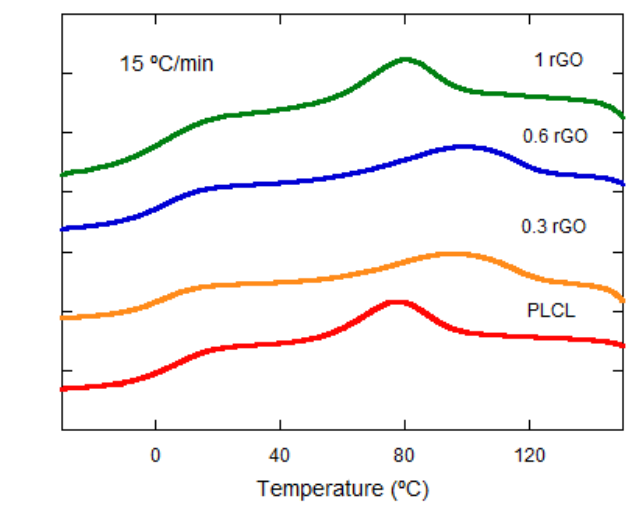
Figure 4. Nonisothermal cold crystallization behavior of neat PLCL and its composites at 15 °C·min −1 from the amorphous state (in the vertical axis, the units are missing).